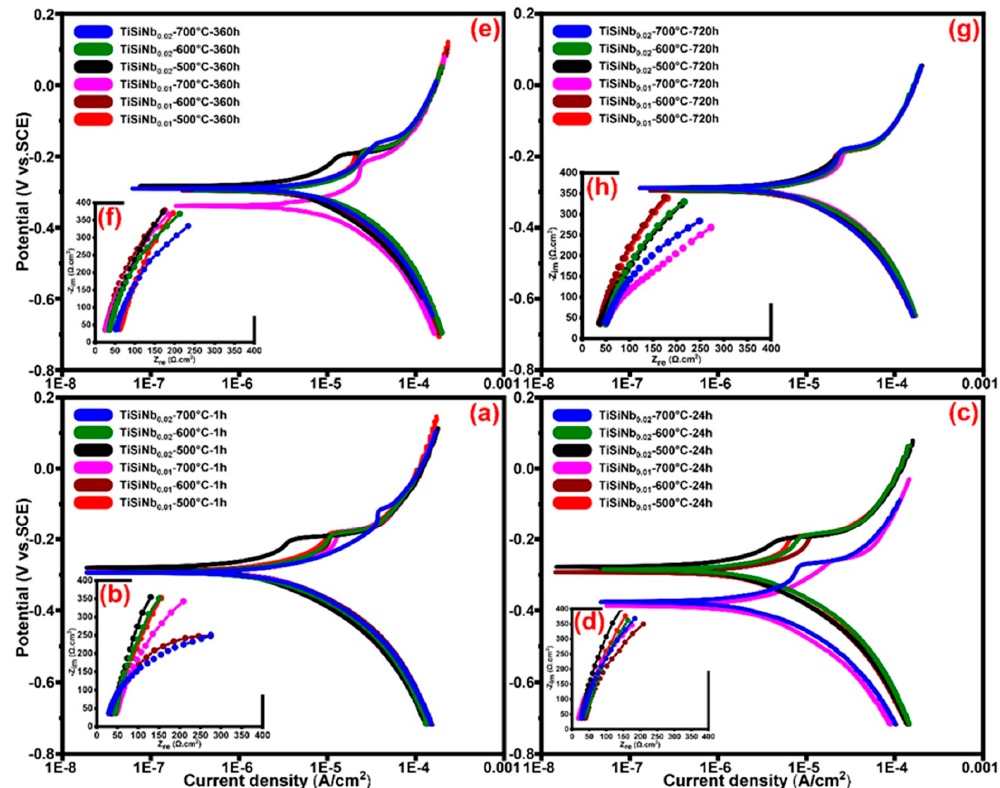
Figure 8. PEP ( a , c , e , g ), EIS ( b , d , f , h ) curves of annealed TFSOC at 500 °C, 600 °C and 700 °C in N 2 atmospheres after immersion in SCS for 1, 24, 360 and 720 h.